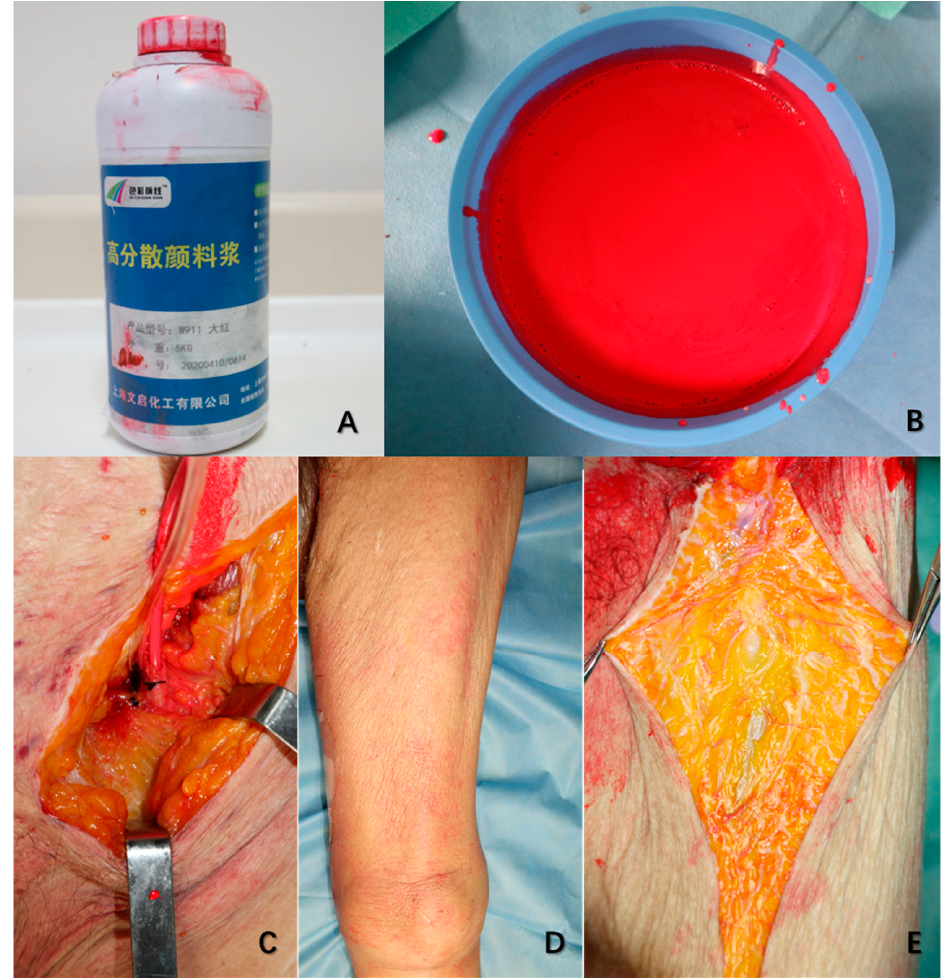
Figure 1. Preparation before the dissection ( A ) is the red polymeric dispersant. ( B ) is the red latex prepared in which the natural latex was mixed thoroughly with the red polymeric dispersant. ( C ) is the perfusion process, and the cadaver is injected with the red latex from B into the femoral artery above the inguinal ligament. ( D ) shows what looks like until the skin of the lower limb flushes pink. ( E ) is just at the beginning of the dissection. The subcutaneous capillaries can be visualized obviously after being perfused with the red latex.